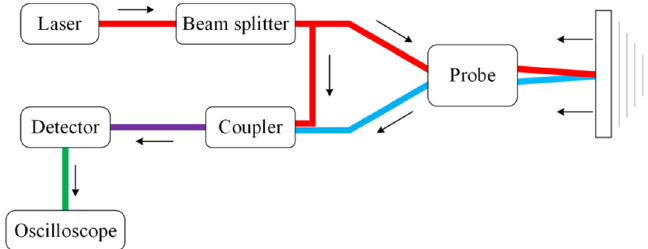
Figure 7. The basic geometry of PDV.